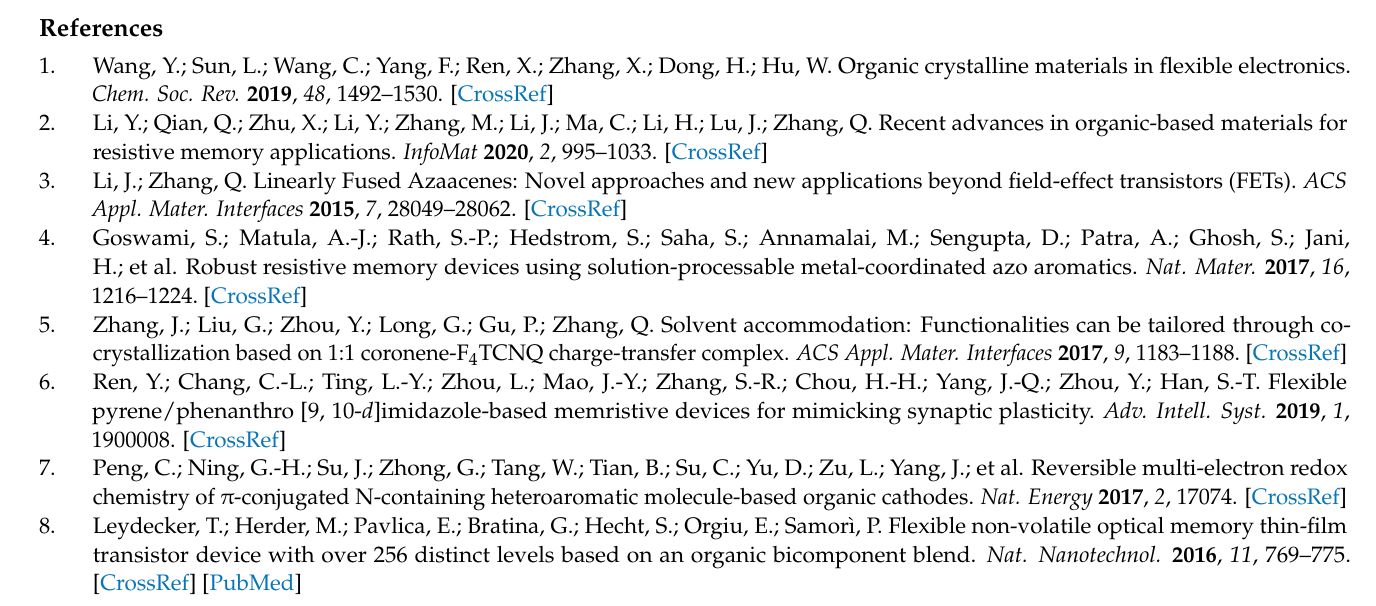
C NMR spectrum of NIBTCN in CDCl 3 ; Figure S5: TGA curve of NIBTCN at a heating rate of 10 ◦ C min − 1 under a nitrogen atmosphere; Figure S6:The cross-sectional SEM image of ITO/NIBTCN/Al device; Figure S7: I – V sweep curves of IRS for the ITO/NIBTCN/Al device; Figure S8: Retention stability of ITO/NIBTCN/Al device at HRS, IRS and LRS; Table S1: Detailed sweep profile and parameters of the device testing; Table S2: Optical and electrochemical properties of